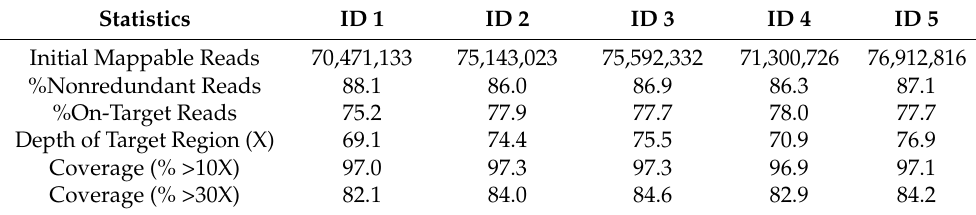
Table 2. Statistics obtained after alignment of reads with the reference